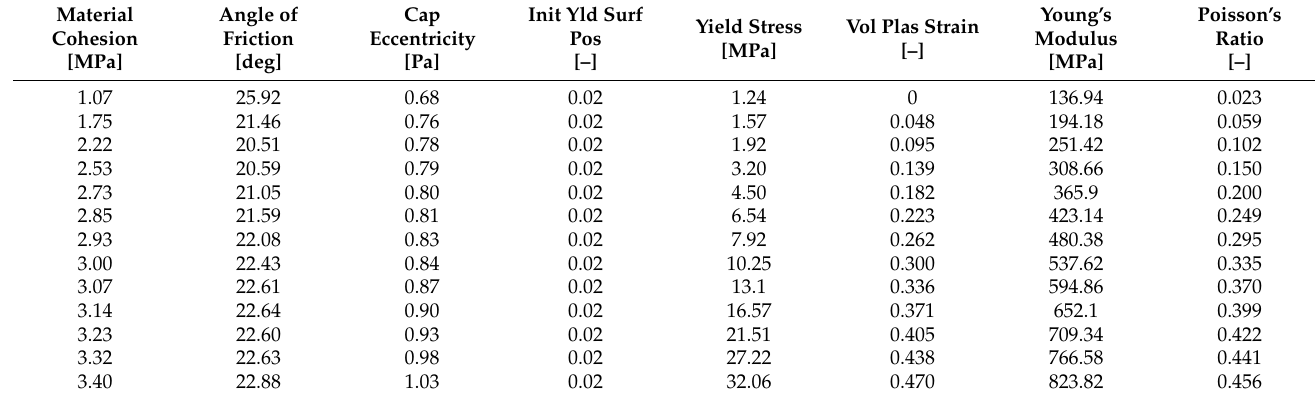
Table 1. Values of DPC model